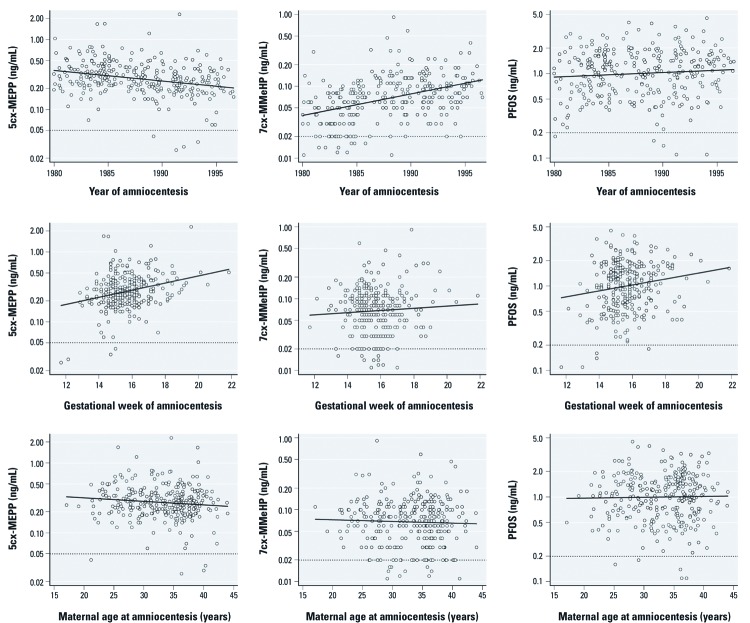
Amniotic fluid 5cx-MEPP (left column), 7cx-MMeHP (middle column) and PFOS (right column) according to year of amniocentesis (top row), gestational week of amniocentesis (middle row), and maternal age at amniocentesis (bottom row): Denmark, 1980–1996. The y-axis scale is natural logarithm (ln). Solid lines are unadjusted linear regressions; dotted lines are LODs for each environmental pollutant.